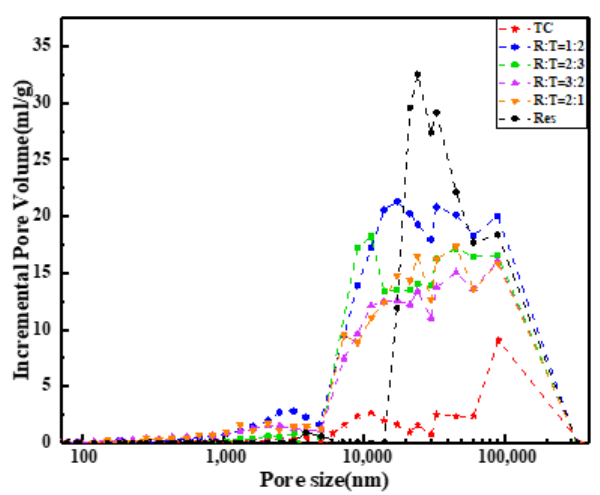
Figure 4. The pore size distribution curve for TC, Res, and the RLTAs.